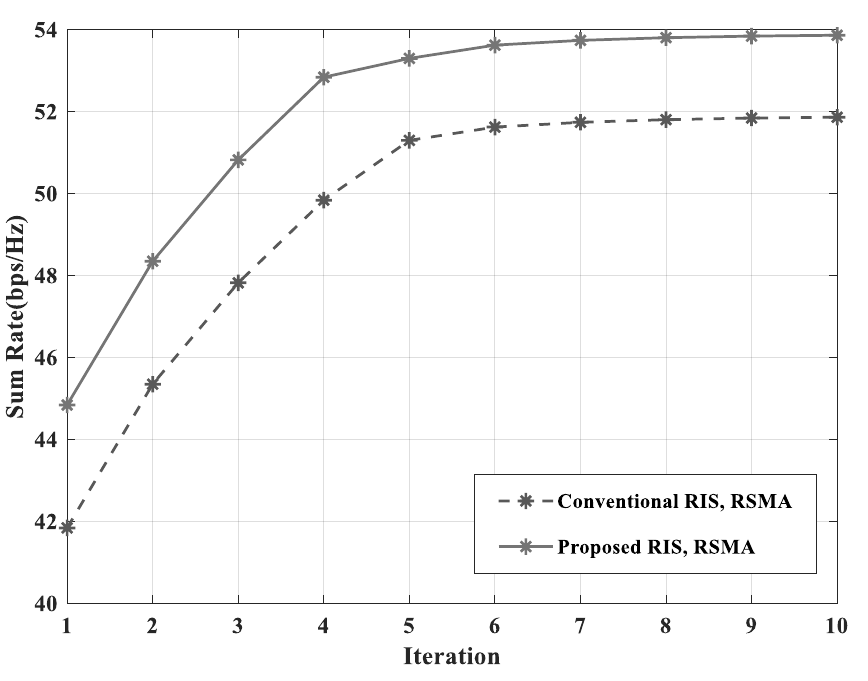
Figure 3. Sum-rate versus iteration with N G = 4 and N I =